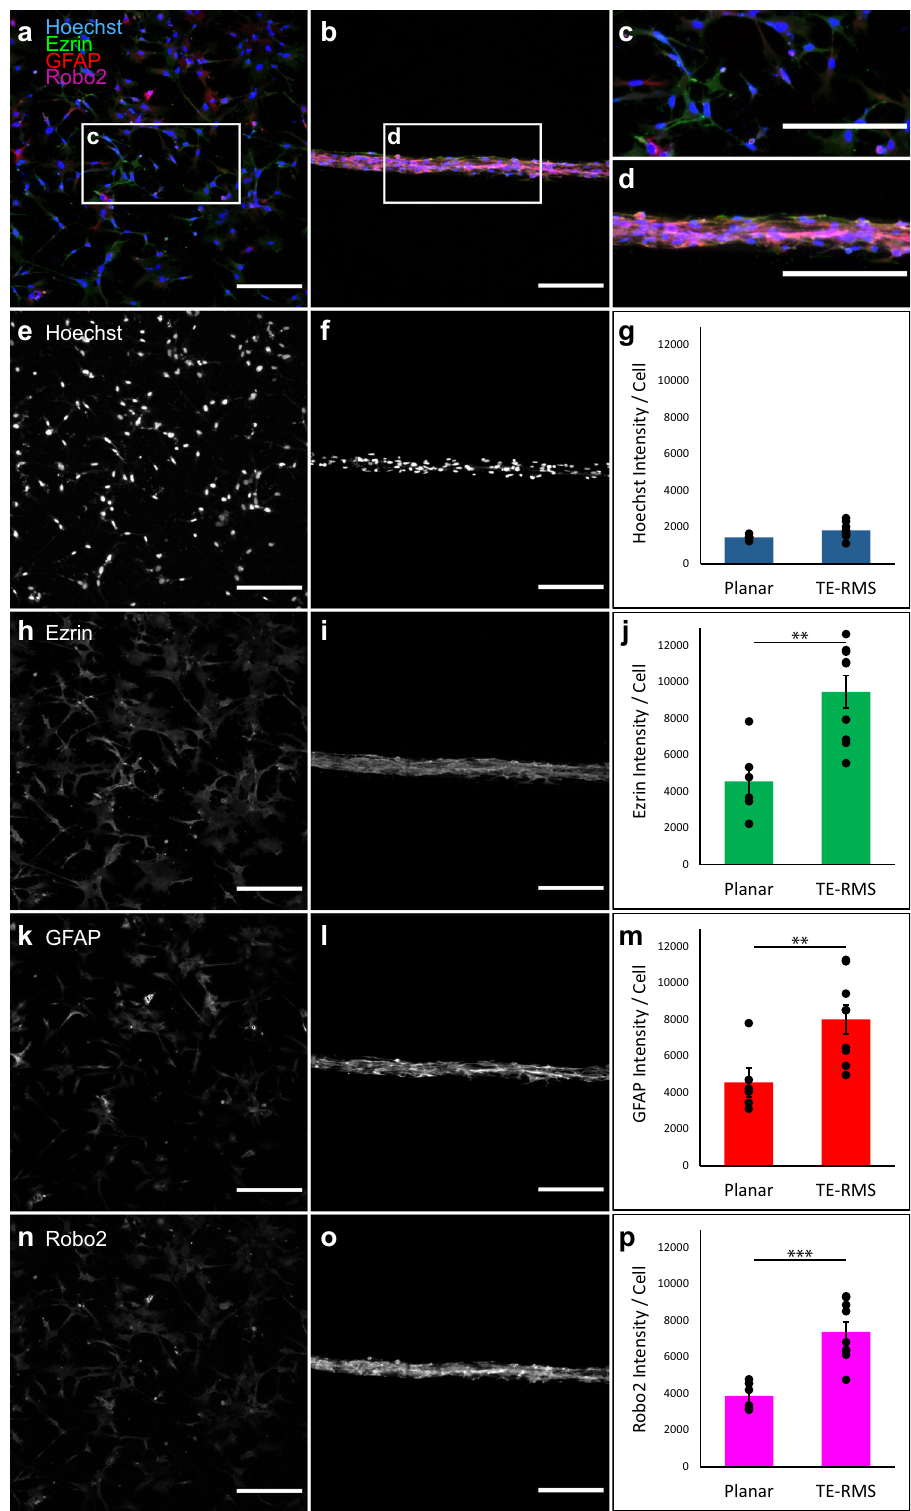
Fig. 3 TE-RMSs fabricated from rat astrocytes are enriched in GFAP, Ezrin, and Robo2 relative to planar sister cultures. Primary rat astrocytes were passaged, split, and either plated in a planar collagen matrix or used for TE-RMS fabrication. Cell nuclei were labeled with Hoechst stain, and cells were immunostained for GFAP, Ezrin, and Robo2. Representative wide views of merged fl uorescent channels are provided for planar sister cultures ( a ) and TE- RMS ( b ), with call-out boxes providing magni fi ed views of planar ( c ) and TE-RMS ( d ) organization, morphology, and relative protein. Maximum contrast white-on-black single-channel images along with quanti fi cation of normalized intensities are provided for Hoechst ( e – g ), Ezrin ( h – j ), GFAP ( k – m ), and Robo2 ( n – p ). Values are displayed as mean ± SEM. Means were compared by Student ’ s t -test. ** p < 0.01, *** p < 0.005. Scale bars: 250